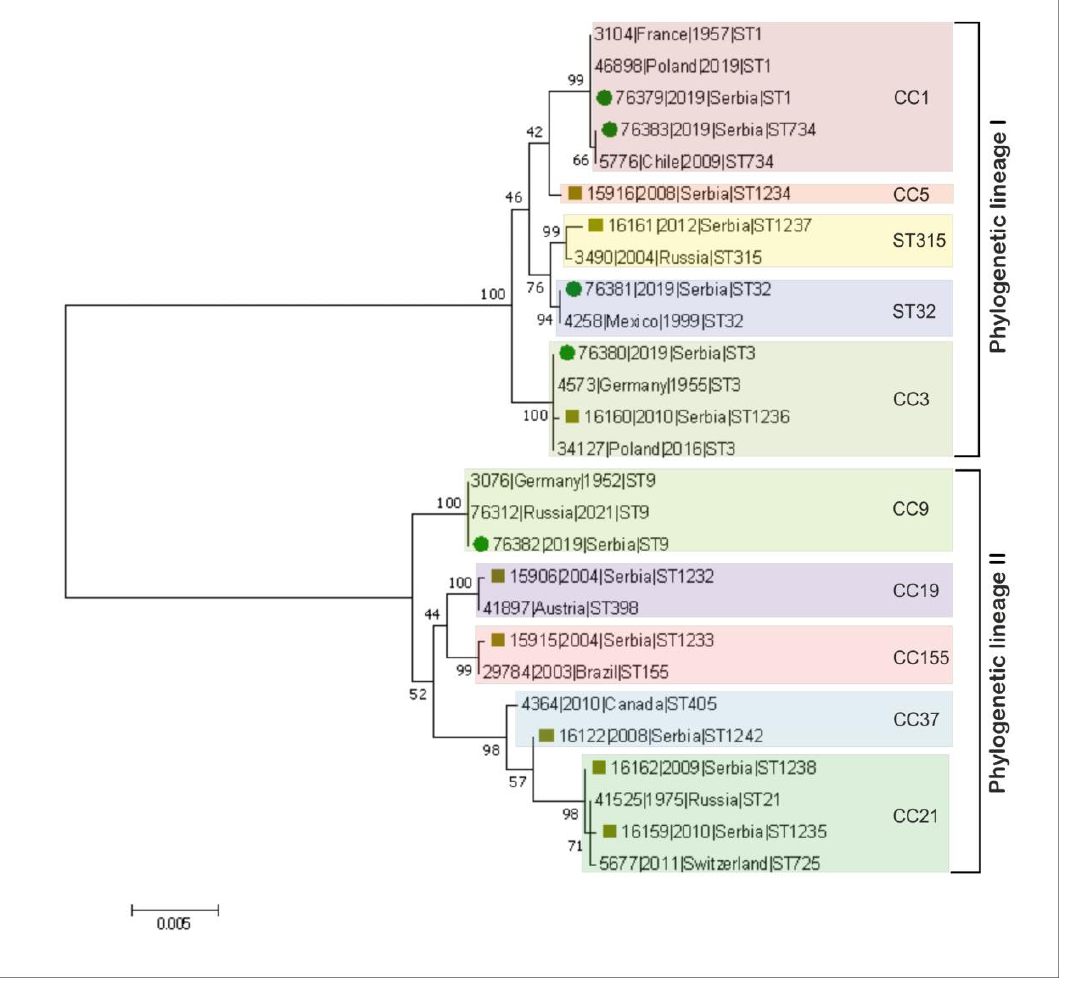
Figure 2. Molecular phylogenetic analysis based on the representative L. monocytogenes concatenated seven housekeeping gene fragments showed the position of strains isolated in the Republic of Serbia in 2019 (green dot) in relation to strains previously isolated in either this country in 2004–2012 (yellow square) or other parts of the world and in which the identical STs and CCs were found. The concatenated sequences were aligned and analyzed in MEGA7 [30]. The trees were constructed using the maximum likelihood algorithm with 1000 bootstrap replicates.